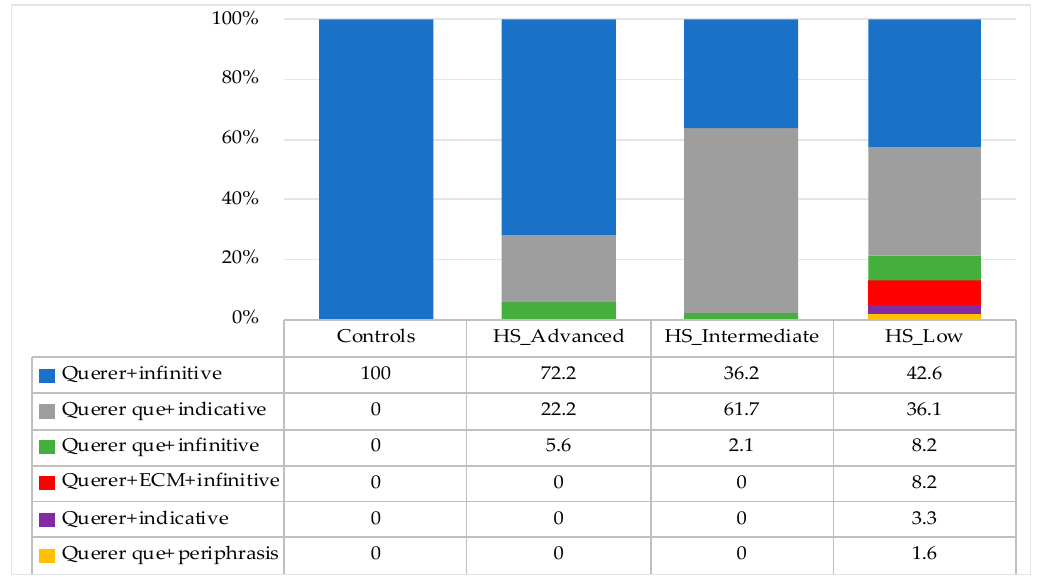
Figure 1. Distribution of divergences produced in the disjoint reference condition.